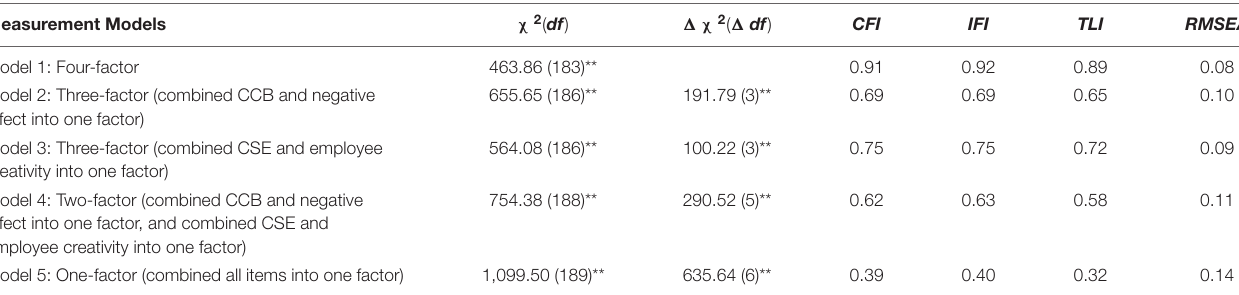
TABLE 1 | Results of confirmatory factor analysis of the measurement models ( N = 251). Measurement